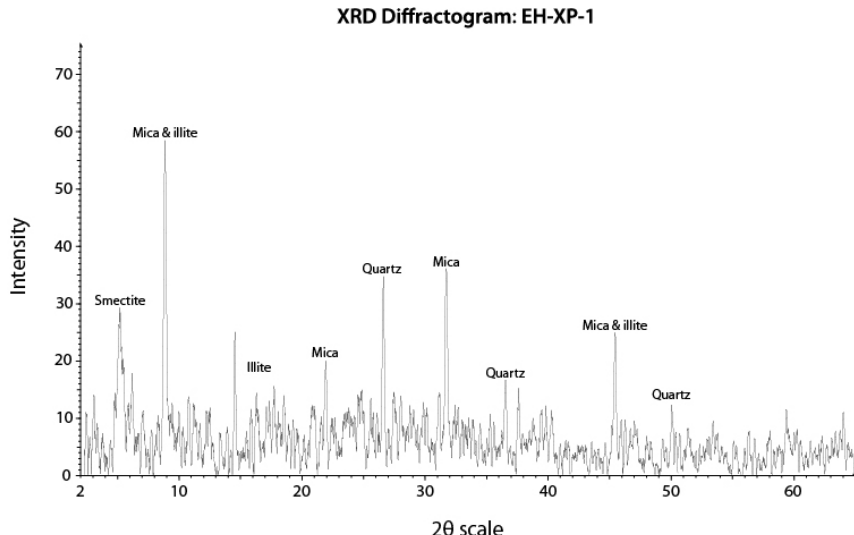
Fig. A2. XRD analysis of sample EH-XP-1 summarised in Table 1. Notably, the comparatively significant ca. 10 ◦ (2Theta) phyllosilicate (mica and illite) peak could wholly or in part represent the illite-type structure characteristic of thermal decomposition products of major primary clay minerals.